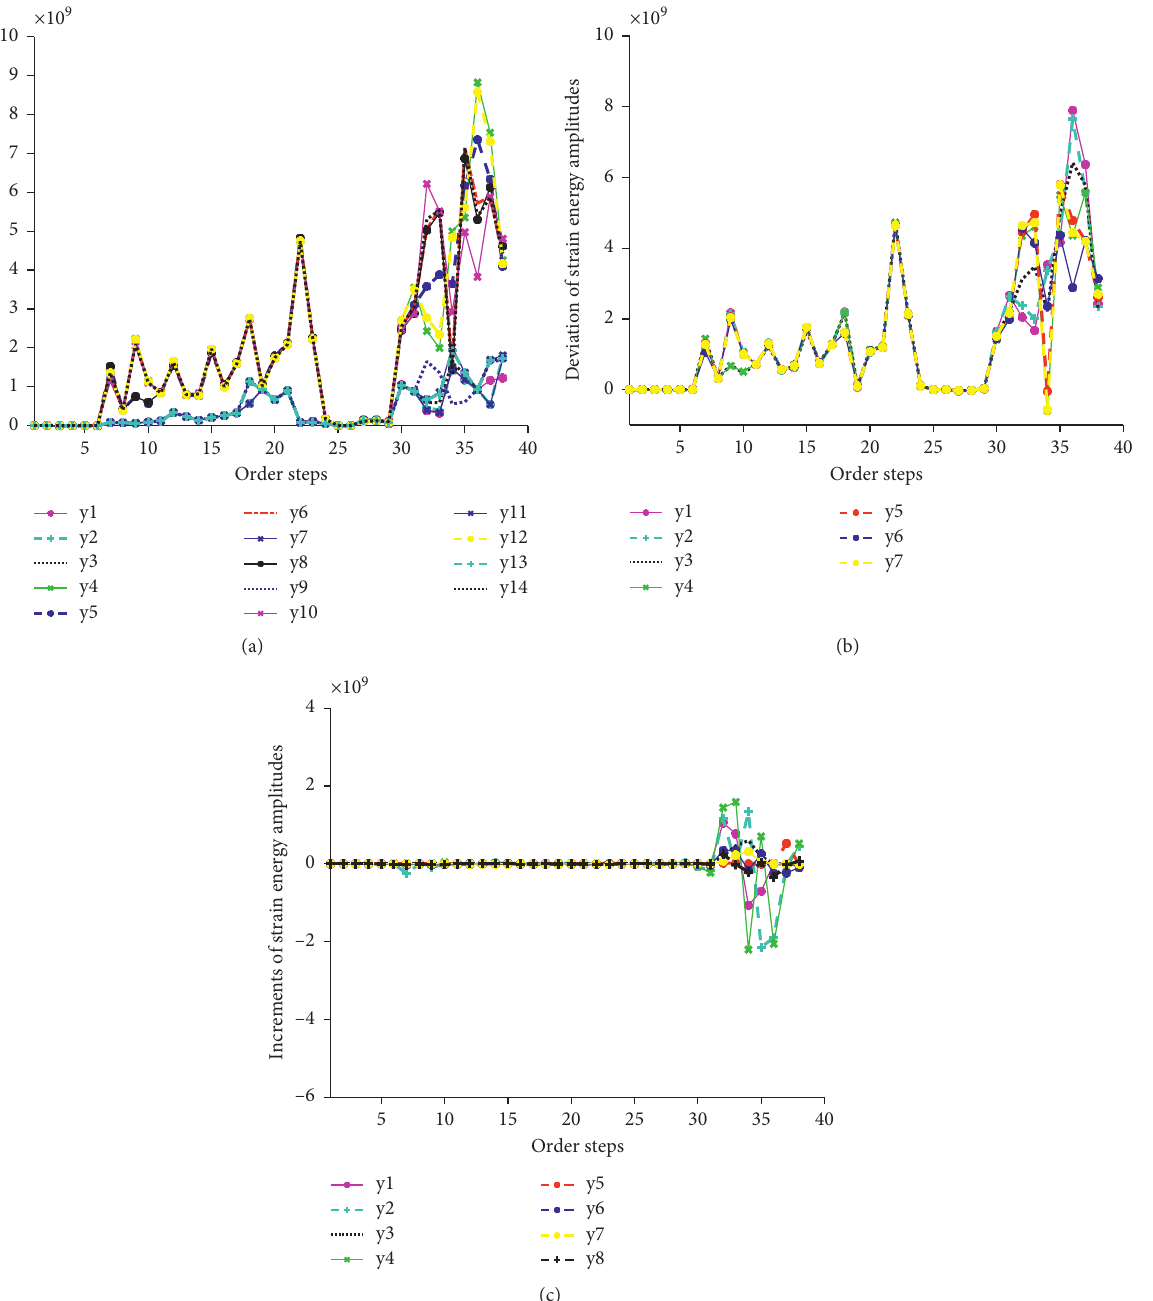
Figure 10: Strain energy amplitudes with centrifugal force and thermal load. (a) SEAs. (b) Deviation of SEAs. (c) Variable quantity of